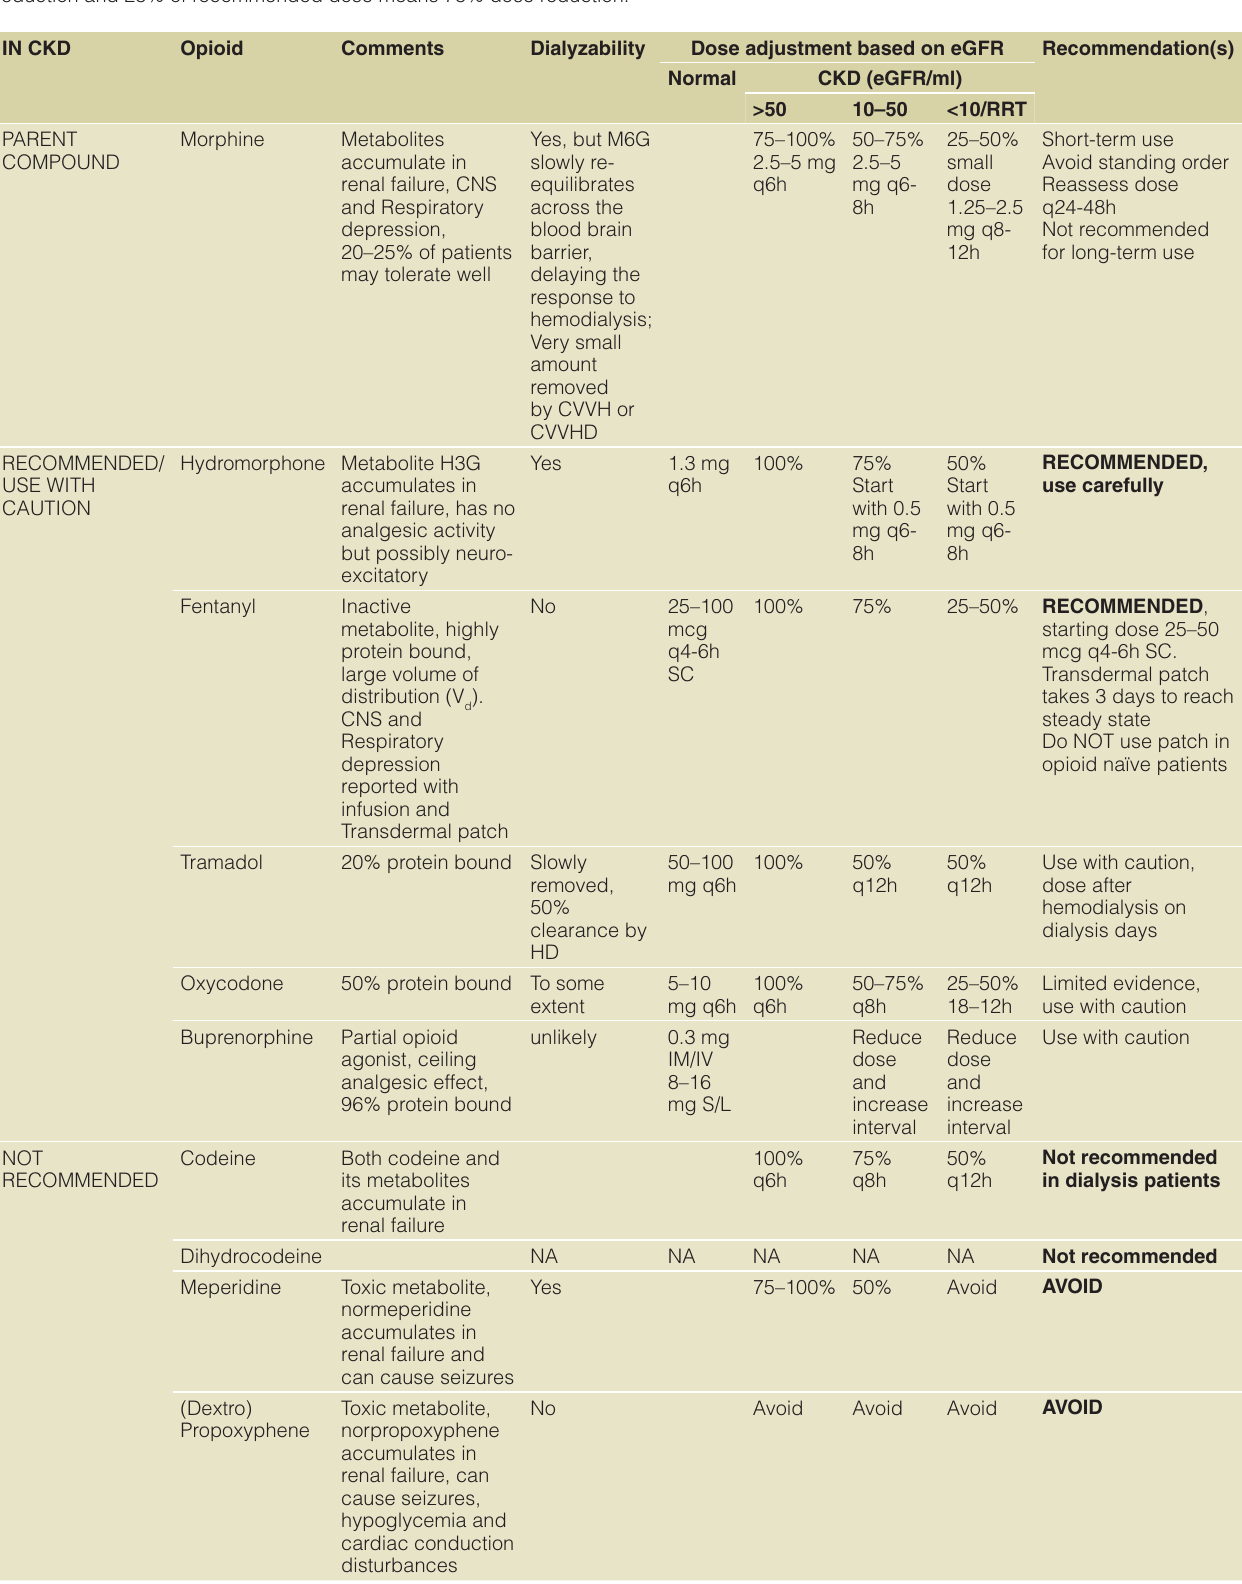
Table 2. Recommendations for commonly used opioids in CKD. The dose adjustment based on eGFR shown is the percentage of recommended normal dose, 75% of recommended dose means 25% dose reduction, 50% of recommended dose means 50% dose reduction and 25% of recommended dose means 75% dose